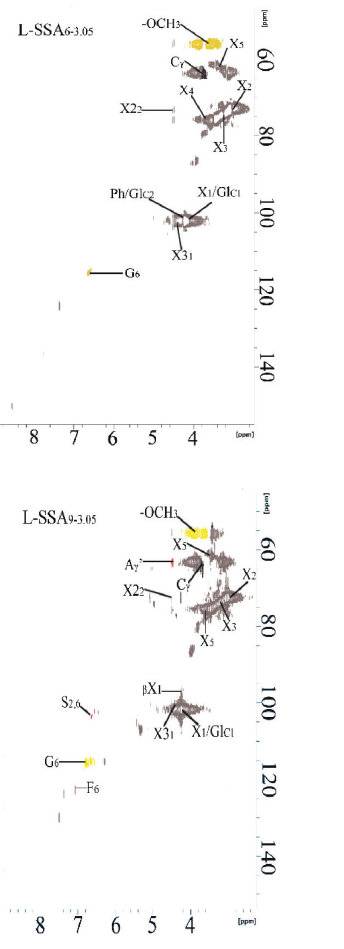
Fig. S2 – 2D HSQc NMR spectrum of l-SSA samples iso - lated from corncob by different steam explosion severities and sodium hydroxide-catalyzed concentrations. l-SSA L-SSA